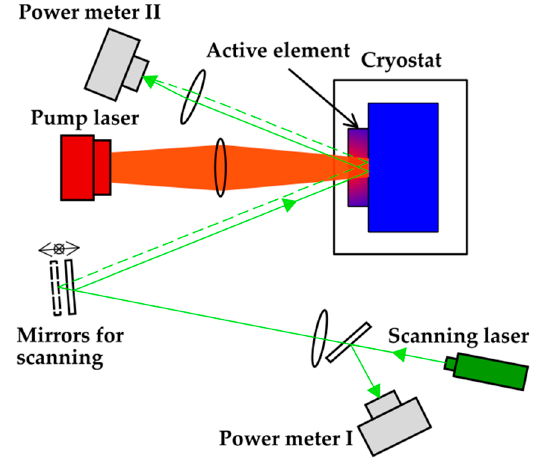
Figure 1. The transmittance map scanning scheme.